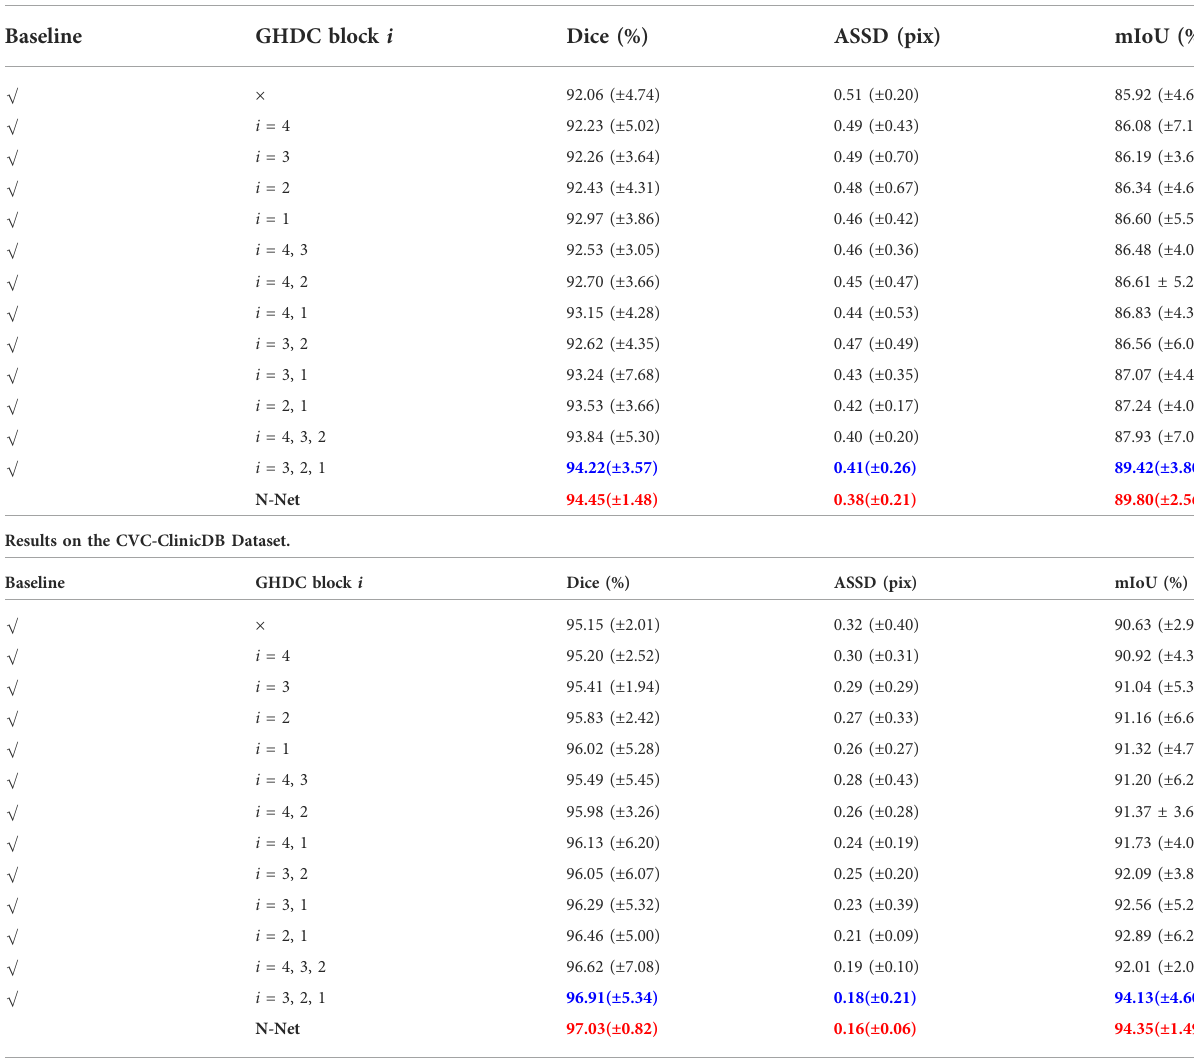
TABLE 3 Ablation Study Results of the GHDC Blocks on the Two Public Datasets of Colorectal Polyp Segmentations (The best results and the second best results are marked in red bold and blue bold fonts, respectively). Results on the Kvasir-SEG